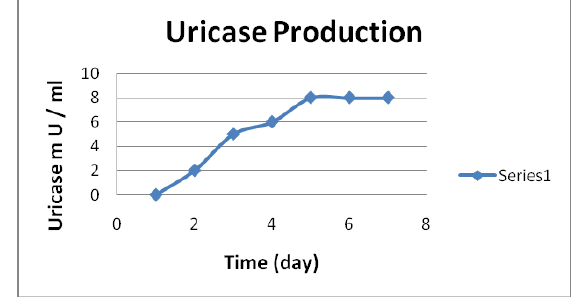
Figure 7. Uricase production during microbial